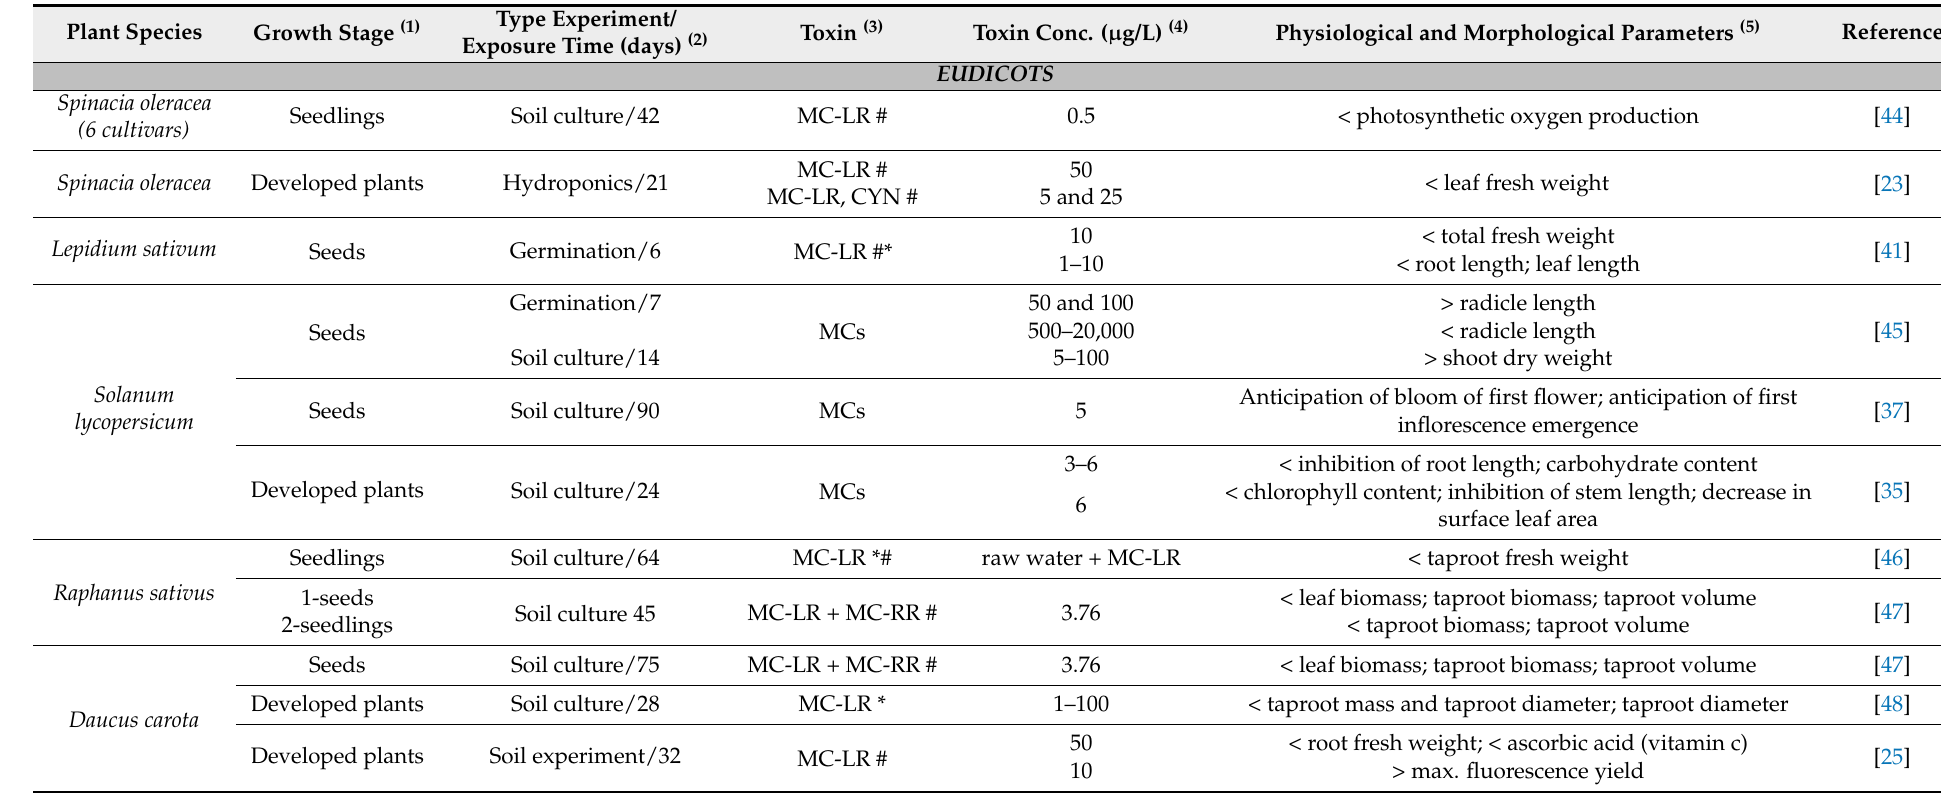
Table 1. Overview of morphological and physiological effects in plants related to MCs concentrations reported in the literature. The information is organized by species and study. Moreover, plant species were ordered on the basis of species sensitivity to MCs, taking into account that this assessment depends on the investigation performed (germination test, hydroponics, soil experiment). No changes observed (nd); relative growth rate (RGR); pure toxin (*); crude extract or natural lake/reservoir water containing MCs (#); information